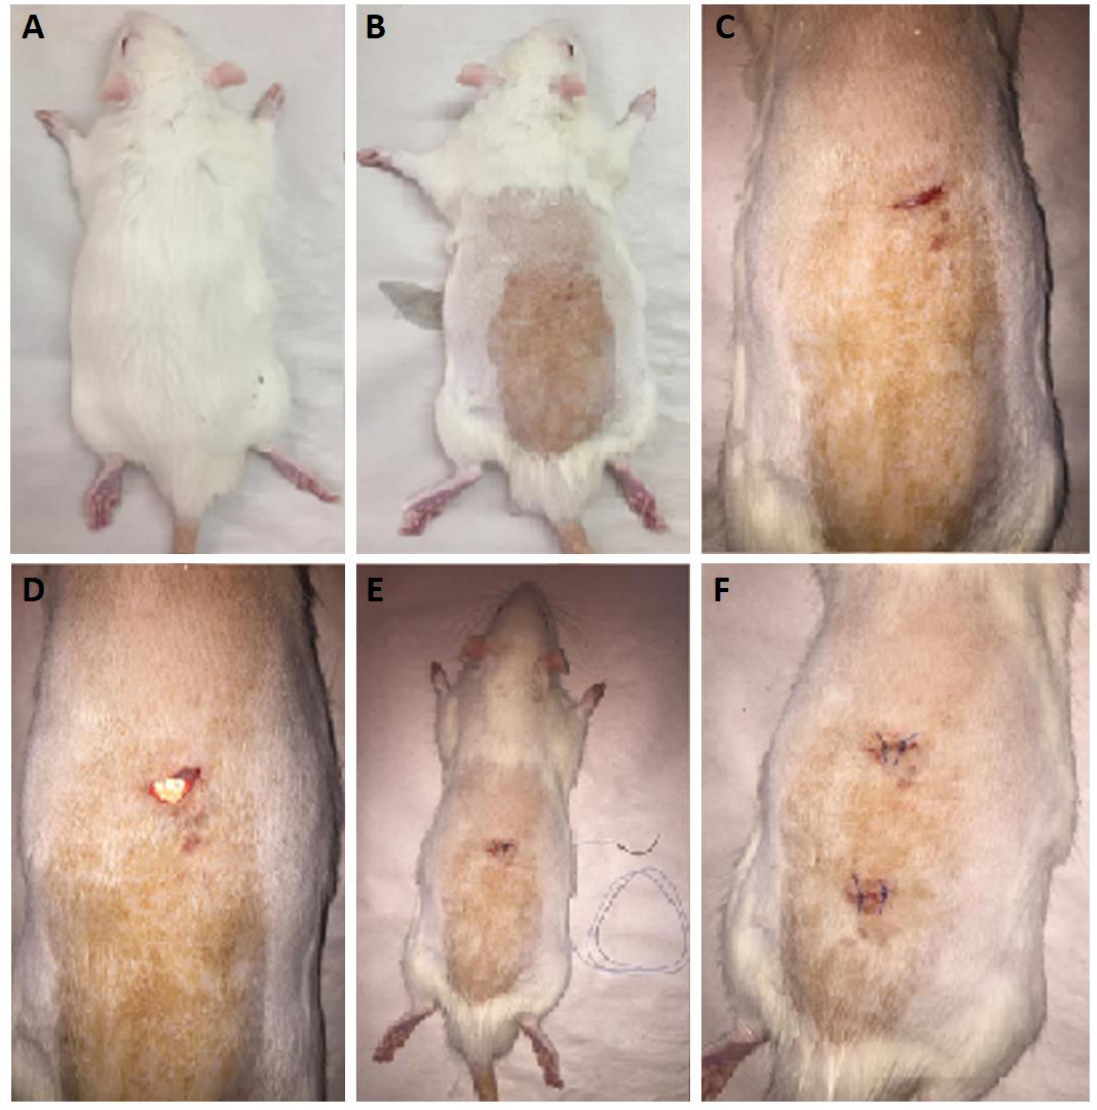
Figure 6. Surgical implantation of nanofibers into rat skin. ( A ) Healthy rat before the procedure; ( B ) anesthetization and shaving of the dorsal part; ( C ) cutting the subcutaneous pocket for implantation; ( D ) placement of nanofibers in the pocket; ( E ) closure of the pocket; ( F ) saturation.